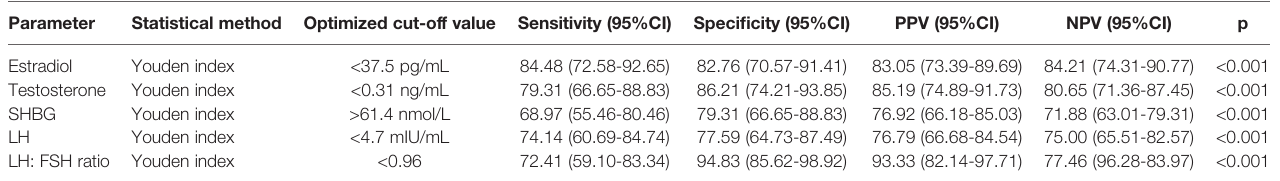
All data are provided as %; PPV, positive predictive value; NPV, negative predictive value.